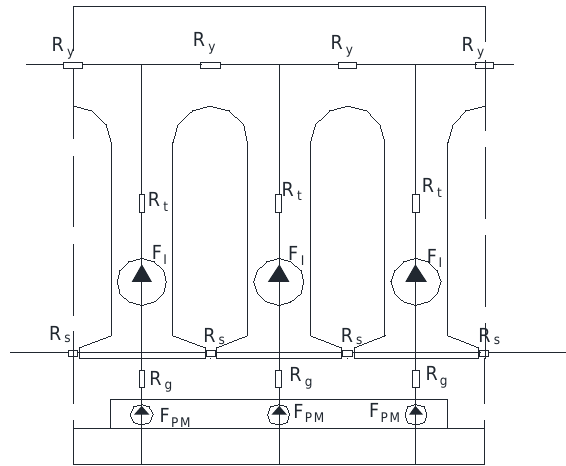
Figure 3. Equivalent magnetic network model of the AFPMSM.